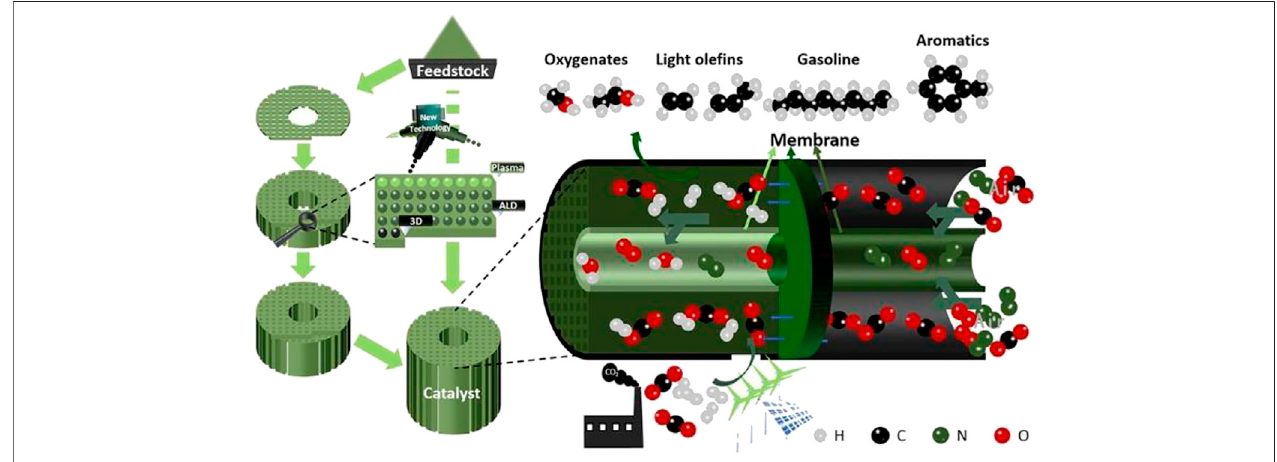
FIGURE 12 | Schematic diagram of CO 2 capture and conversion process and industrialization process of catalysts assisted by new technologies.